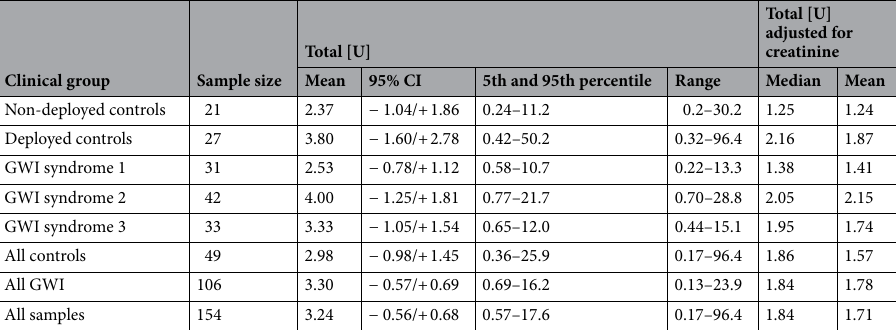
Table 2. Urinary excretion rate of total U by Gulf War veterans’ clinical